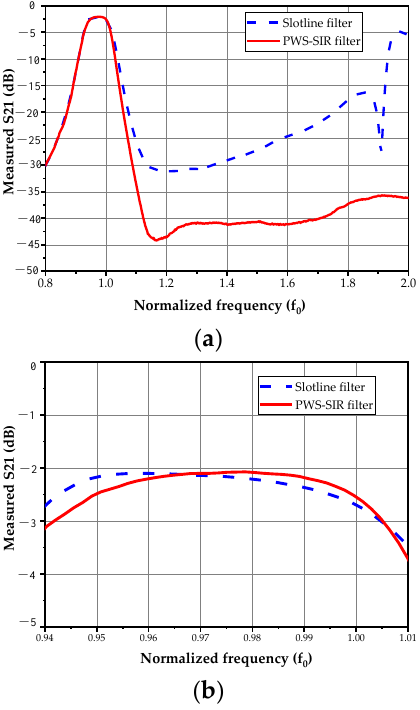
Figure 6. The insertion loss ( a ) and the upper stopband rejection ( b ) comparisons of the conventional slotline filter and the PWS-SIR filter at normalized frequency.